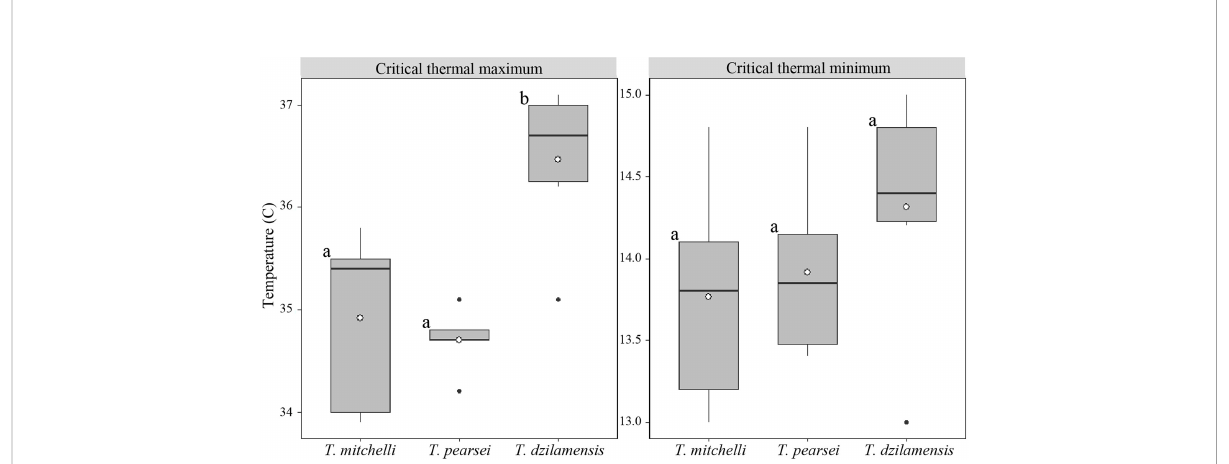
FIGURE 4 Critical thermal maximum and minimum of T. mitchelli , T. pearsei and T. dzilamensis . The black line in each box shows the median of each group, the white dot the mean, the whiskers extend to an extreme data not greater than two standard deviations and the black dots represent outliers. Different letters represent means that resulted signi fi cantly